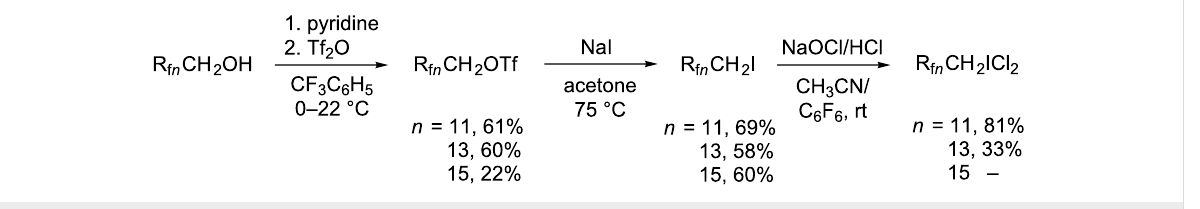
Scheme 2: Syntheses of fluorous compounds of the formula R f n CH 2